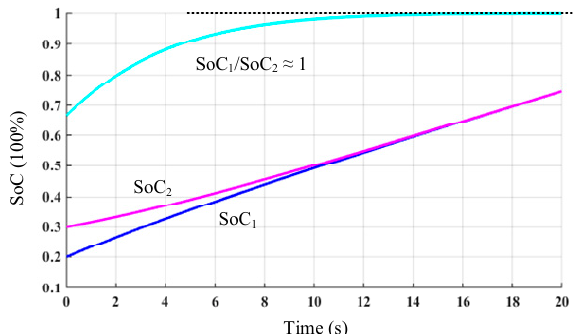
Figure 9. Increasing SoC in the charging process.